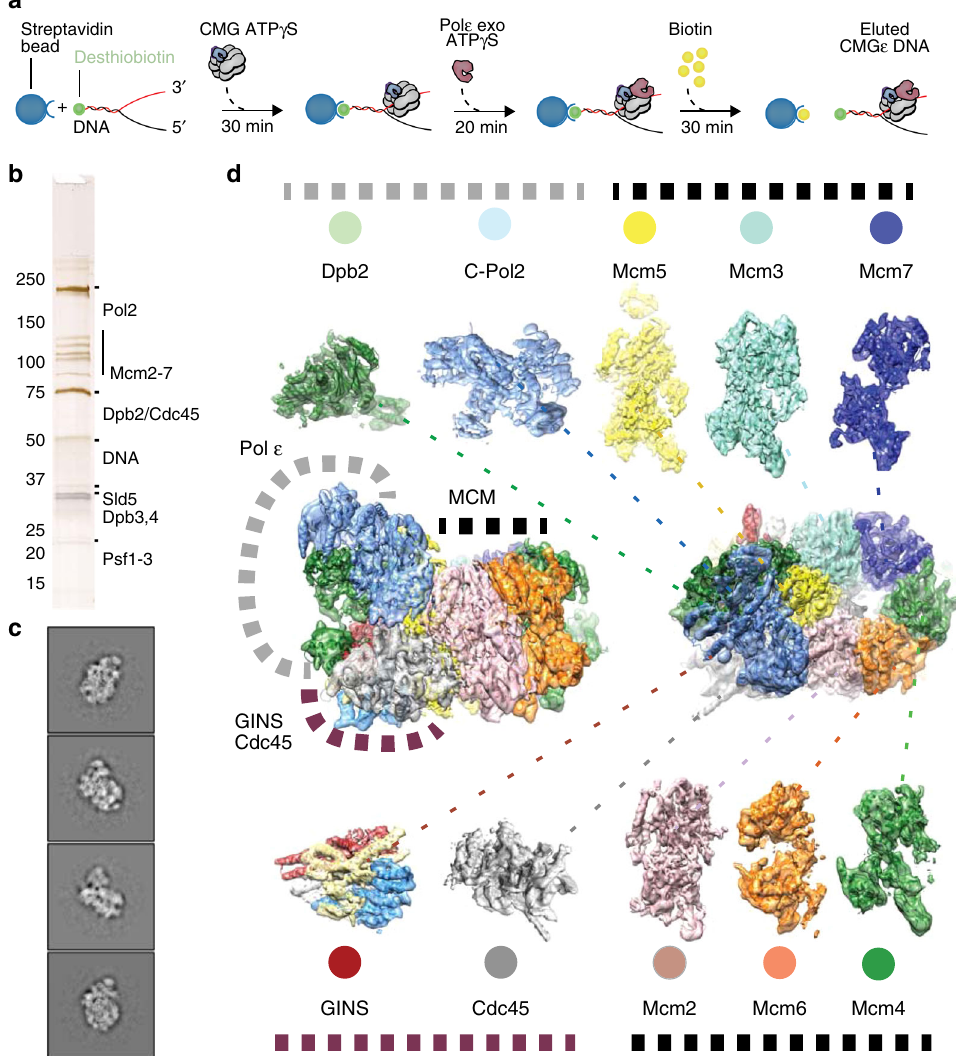
Fig. 4 Cryo-EM structure of CMG-Pol epsilon. a Diagram of the reconstitution of CMG-Pol epsilon on a pre-formed fork. CMG stands for Cdc45-MCM- GINS. b Silver-stained SDS-PAGE gel of the reconstituted CMG-Pol epsilon-DNA complex. c Two-dimensional class averages of the CMG-Pol epsilon-DNA complex. d Cryo-EM structure of CMG-Pol epsilon with docked/real-space re fi ned homology models of CMG and C-Pol2/Dpb2